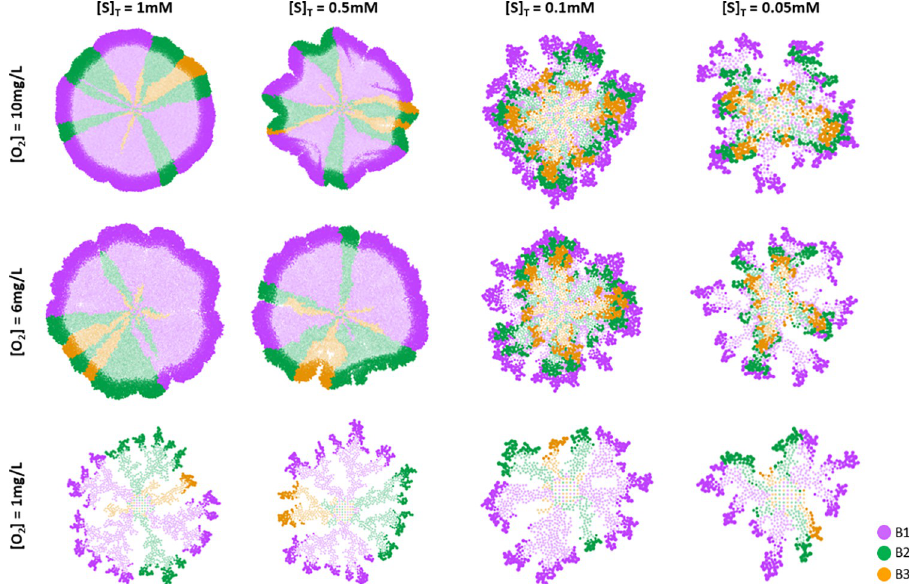
Fig 6. Aggregates captured at steady state considering commensalism and competition for O 2 . Steady state times: 50d for [S] T = 1.0 mM, 0.5 mM, 0.1 mM and [O] 2 = 10 mg/L, 6 mg/L; 75d for [S] T = 1.0 mM, 0.5 mM, 0.1 mM and [O] 2 = 1 mg/L; 100d for [S] T = 0.05 mM and [O] 2 = 10 mg/L, 6 mg/L, 1 mg/L. Inactive bacteria are shown in a lighter colour. Substrate profiles on the transverse plane of aggregates have been included on S5 Fig. Aggregates captured at steady